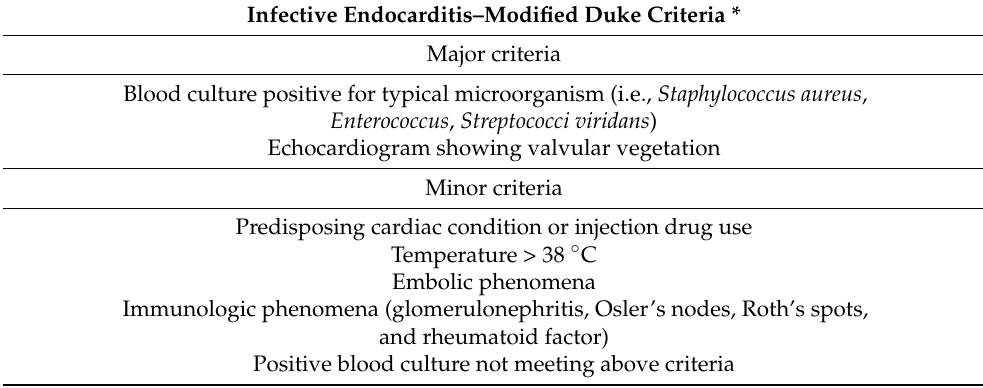
Table 3. Modified Duke criteria for diagnosis of infective endocarditis.